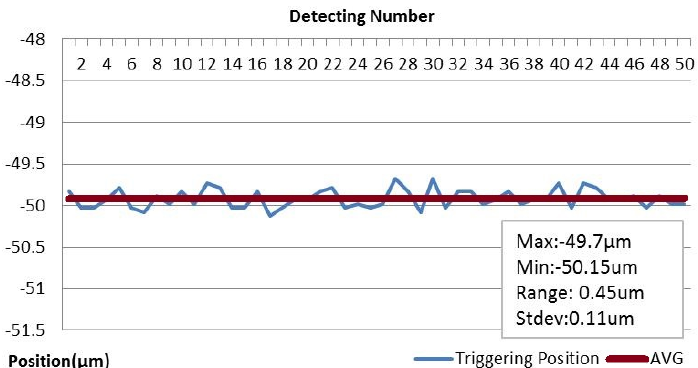
Figure 7. Detection uncertainty in the vertical z ‐ axis direction.